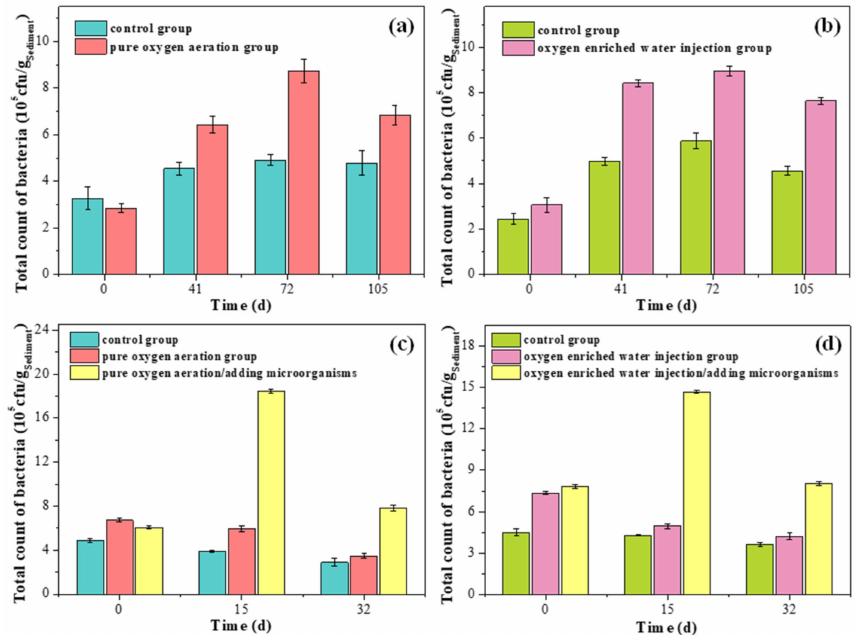
Figure 9. The e ff ects of ( a ) pure oxygen aeration treatment and ( b ) oxygen enriched water injection treatment on the total count of bacteria in the sediment; ( c , d ) the e ff ects of adding microorganisms on the total count of bacteria in the